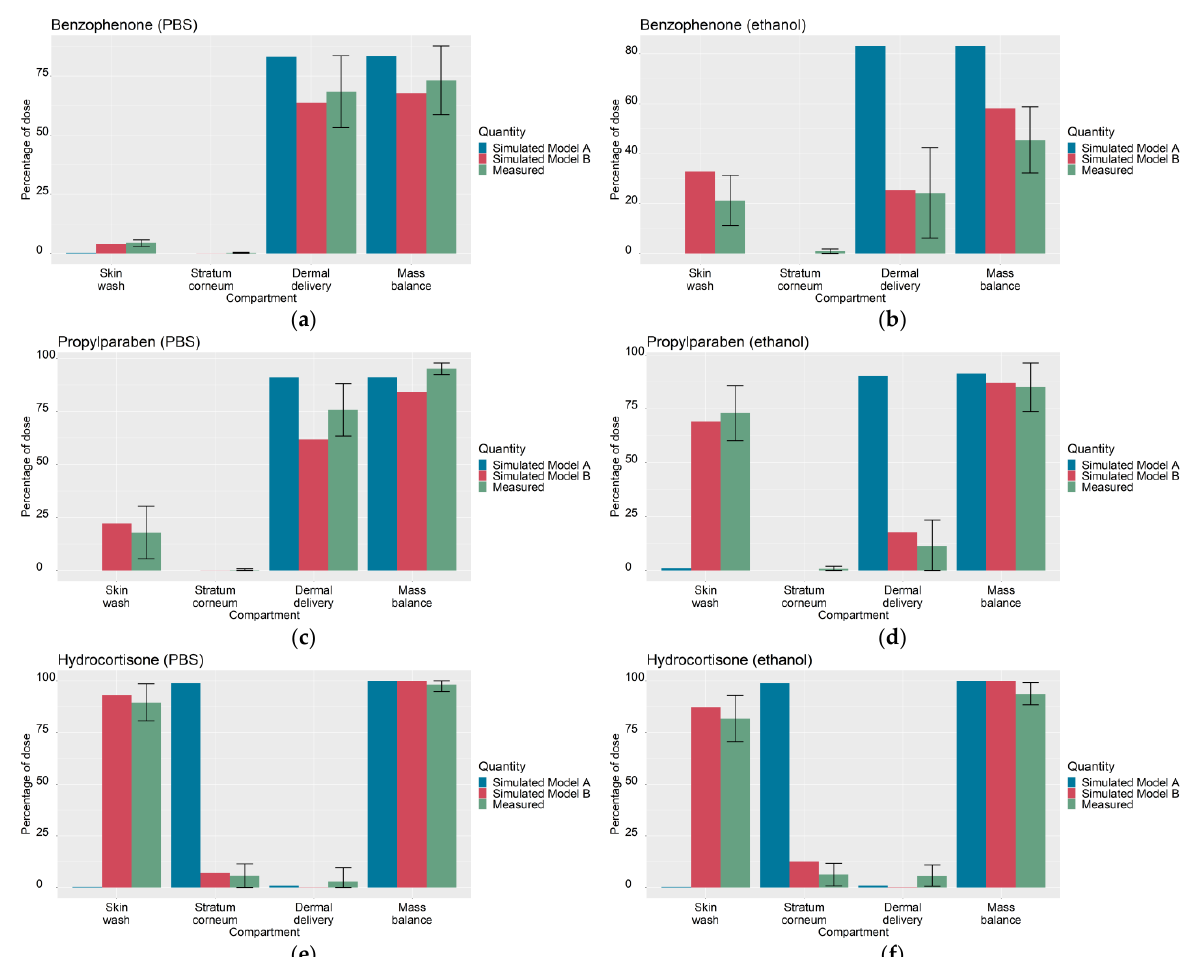
Figure 1. Simulated outputs of optimized Models A and Model B (skin wash, stratum corneum accumulation, cumulative dermal delivery and mass balance at 24 h) and corresponding experimental measurements (from [5]) used to calibrate (for Model A) the wind velocity 𝑢 𝐴 and (for Model B), the wind velocity 𝑢 𝐵 , the deposition layer proportions of the SC ( 𝜂 𝑑𝑒𝑝𝑝𝑏𝑠 , 𝜂 𝑑𝑒𝑝𝑒𝑡ℎ𝑎𝑛𝑜𝑙 ) and the vehicle evaporation rate ( 𝑘 𝑒𝑣𝑎𝑝−𝑣𝑒ℎ𝑝𝑏𝑠 , 𝑘 𝑒𝑣𝑎𝑝−𝑣𝑒ℎ𝑒𝑡ℎ𝑎𝑛𝑜𝑙 ) under PBS and ethanol solvents; ( a ) benzophenone in PBS, ( b ) benzophenone in ethanol, ( c ) propylparaben in PBS, ( d ) propylparaben in ethanol, ( e ) hydrocortisone in PBS, ( f ) hydrocortisone in ethanol. The total root sum of squares error, defined in Table A4 , is 252.5 for Model A and 190.4 for Model B.